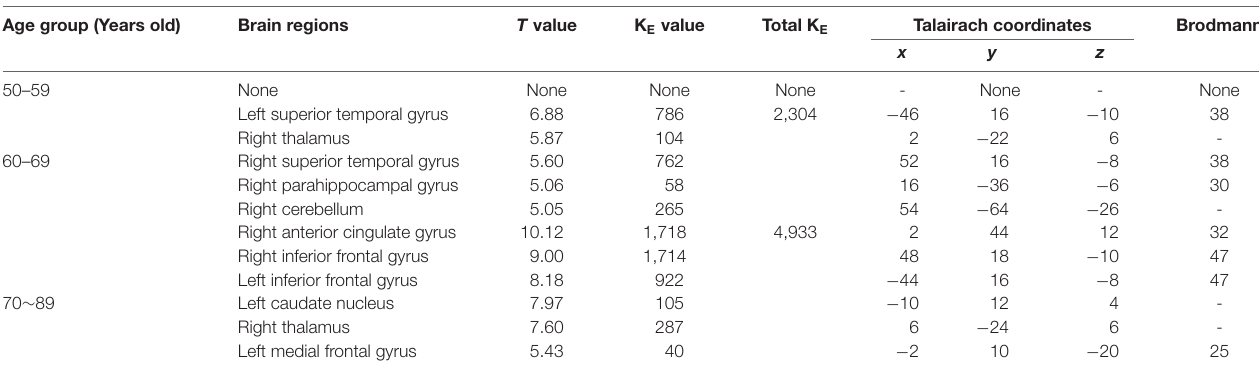
TABLE 2 | Brain regions with decreased metabolism in cohort.